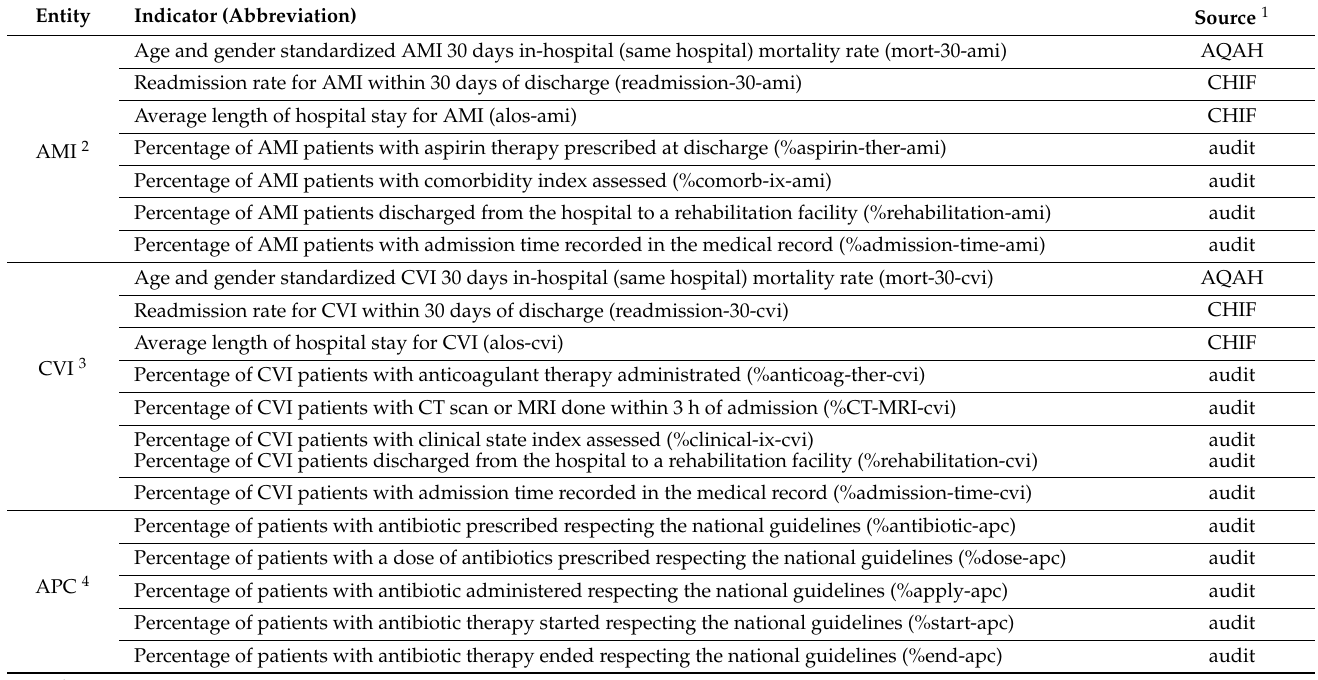
Table 1. Indicators and sources of data by clinical